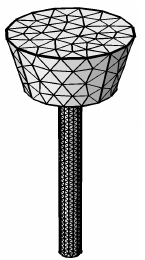
Figure 8. Three-dimensional model and mesh.